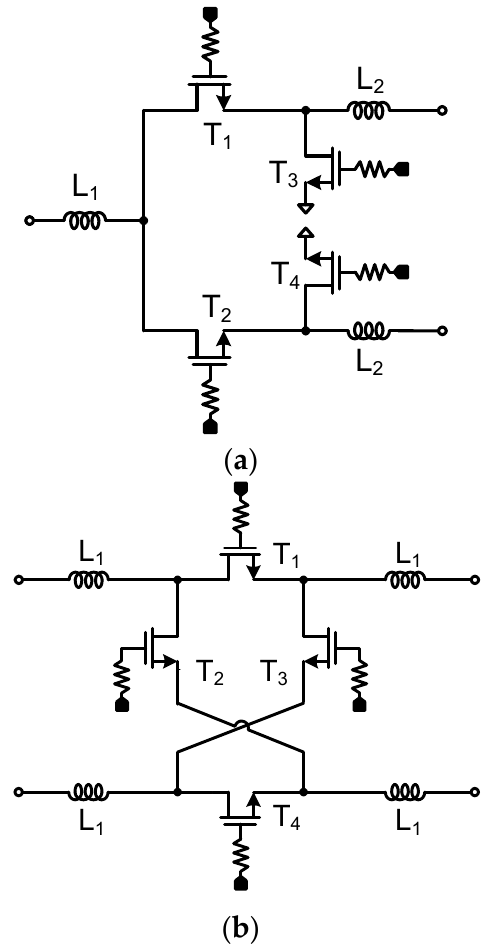
Figure 4. Schematic of ( a ) the GaN SPDT and ( b ) the GaN DPDT switch.